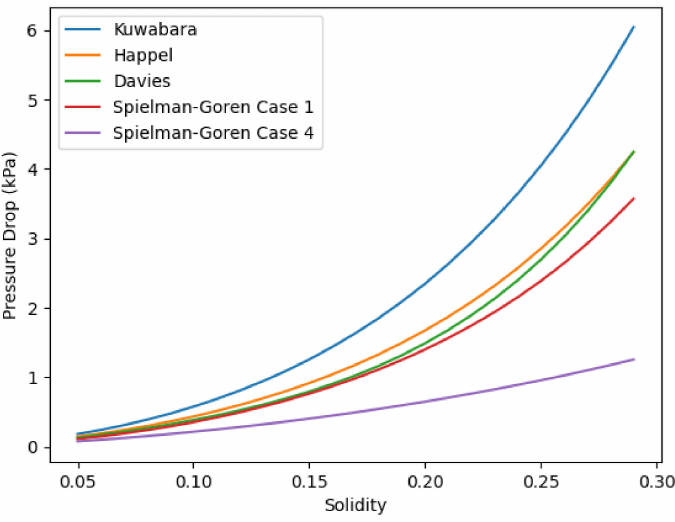
Figure 1. Pressure drop versus solid fraction for different analytical and empirical